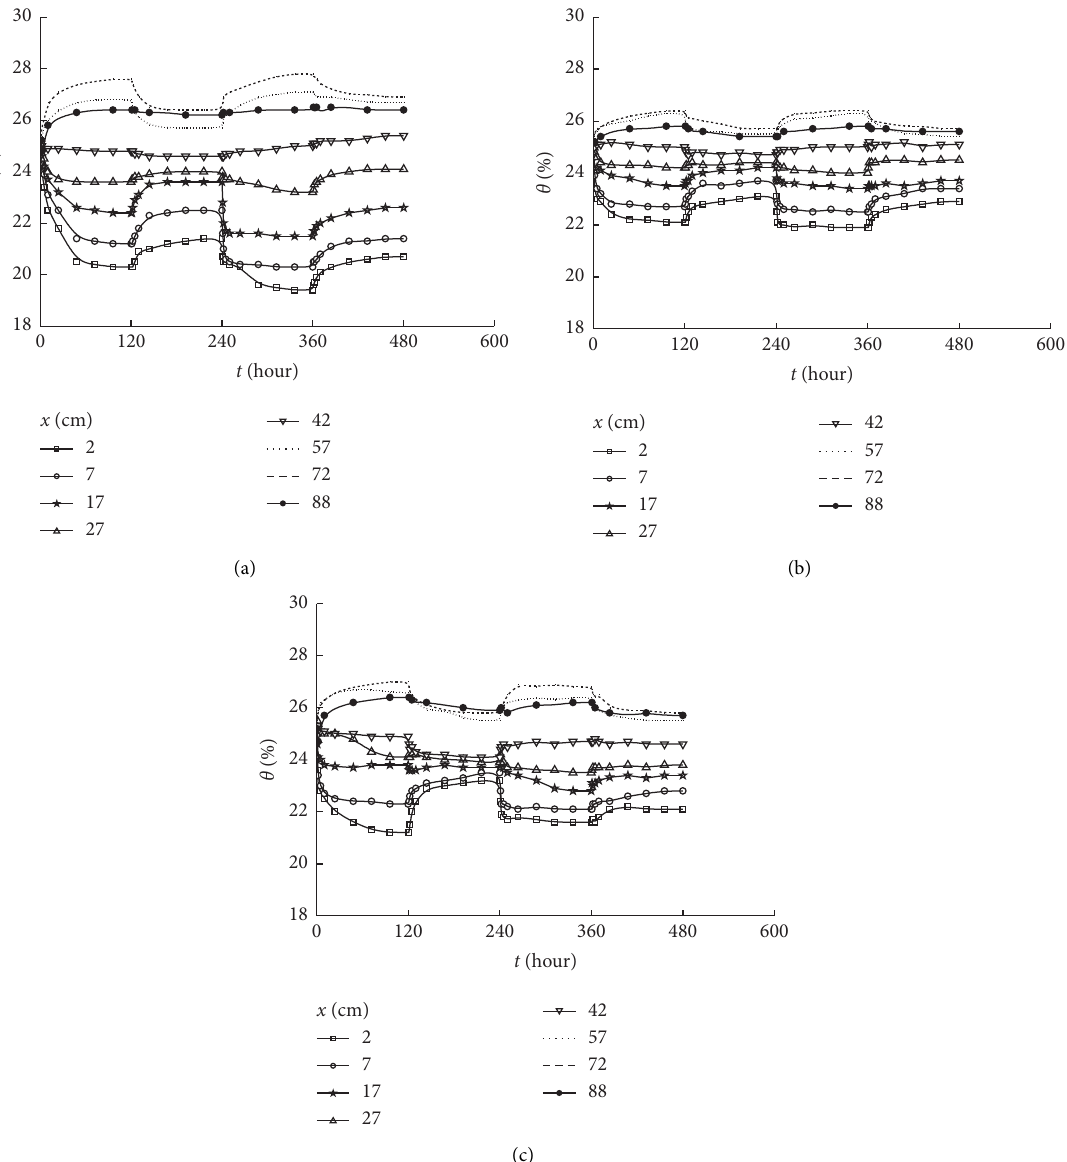
Figure 4: Moisture evolution processes over time for the two heating cycles: (a) horizontal placement, (b) vertical placement and top heating, and (c) vertical placement and bottom